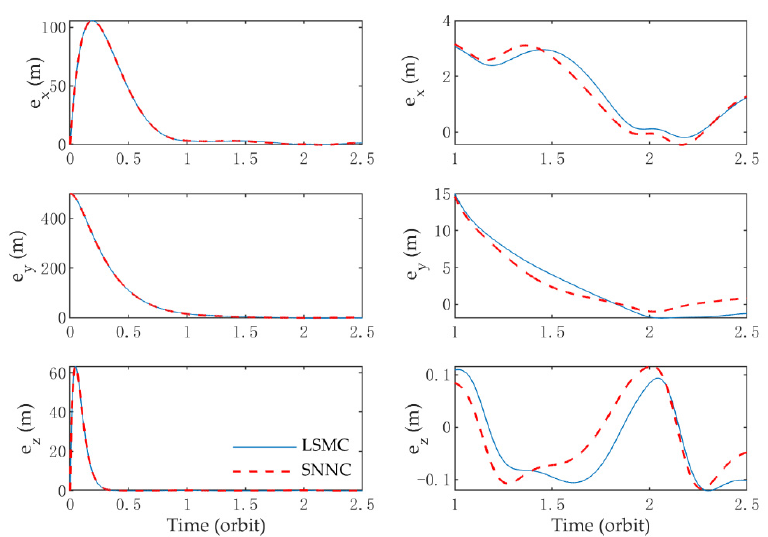
Figure 6. Time histories of relative position errors for the case without in-track control.